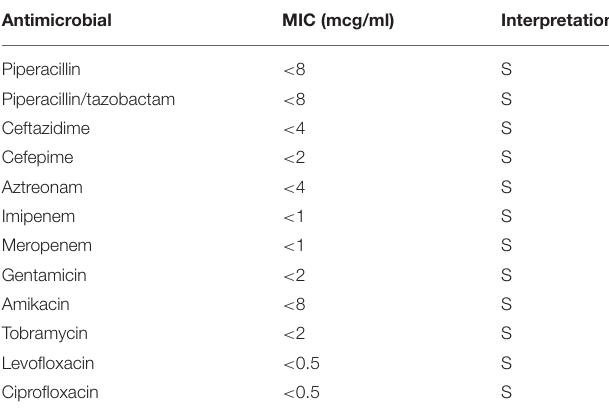
TABLE 1 | Antimicrobial susceptibility profile of the Pseudomonas aeruginosa isolated from CSF and sponge brush.